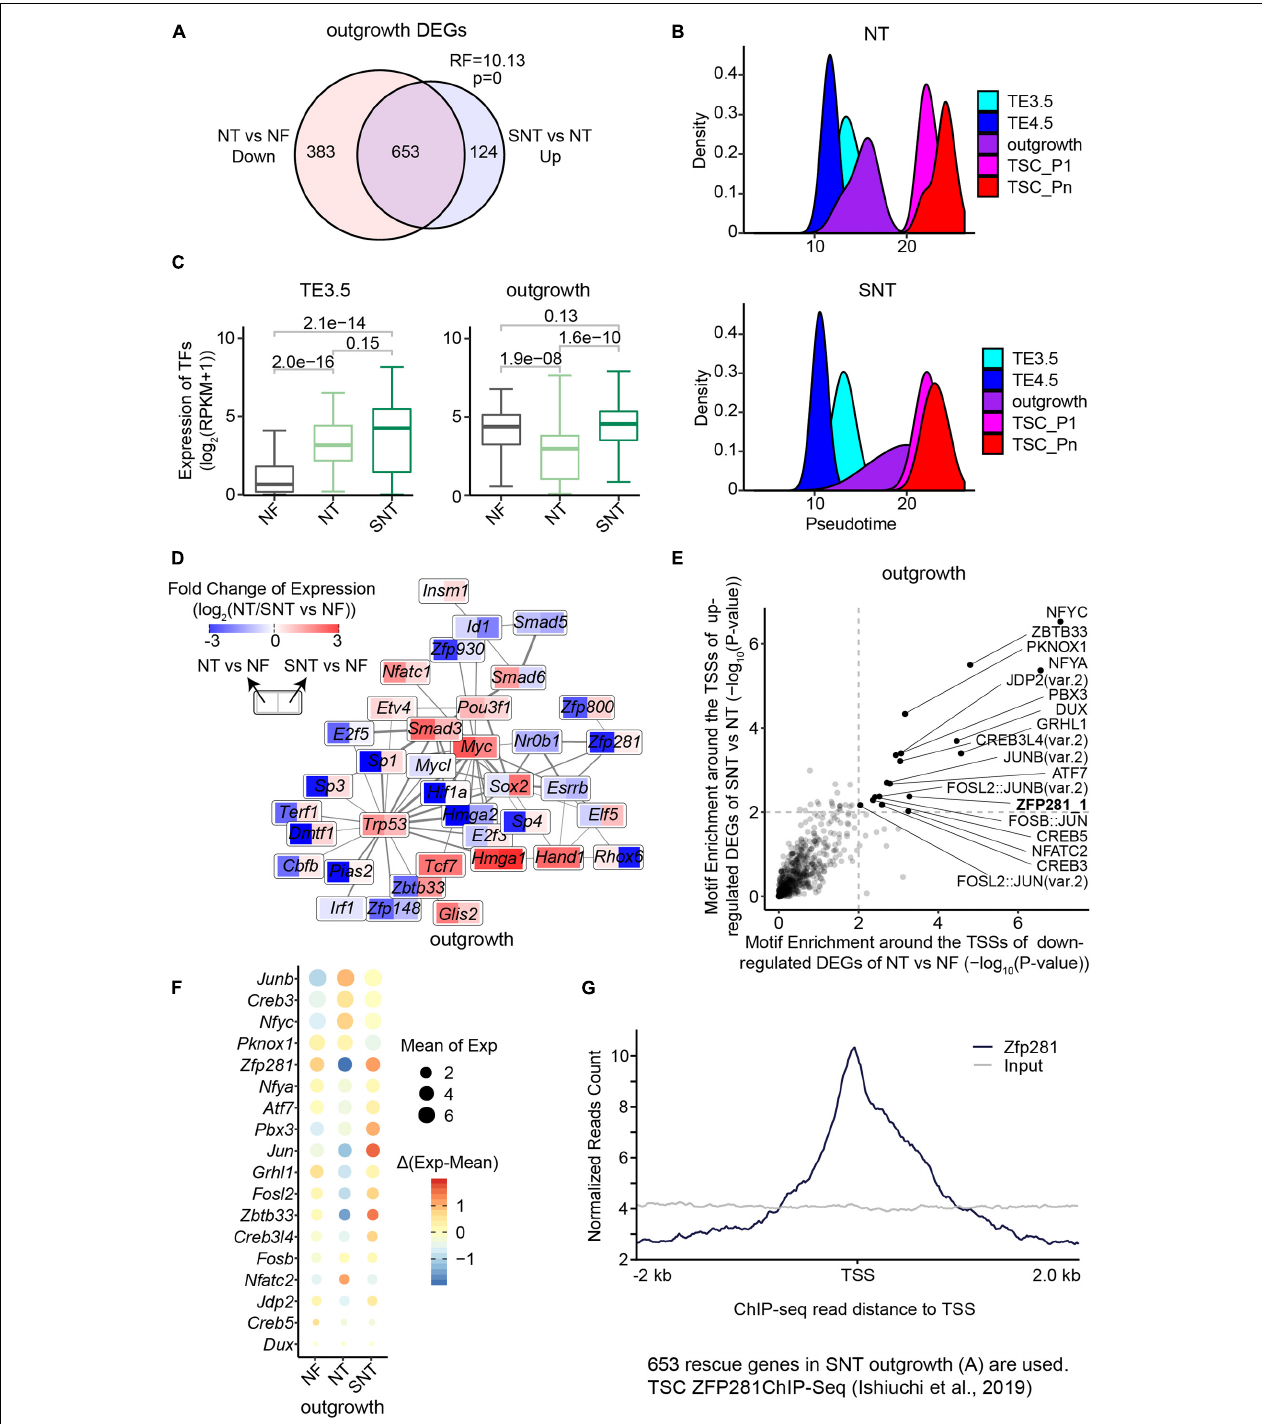
FIGURE 3 | Downregulated genes in NT outgrowth are largely rescued in SNT outgrowth. (A) Venn diagrams showing the intersection between the downregulated genes in NT outgrowth compared with NF outgrowth and the upregulated gene SNT outgrowth compared with NT outgrowth. Representation factor (RF) was calculated using real observation/expected observation. The statistical analysis is hypergeometric test with all expressed genes at outgrowth as background. The intersection genes are defined as the rescued genes. (B) The pseudotime of NT (top) or SNT (bottom) TSC derivation inferred from the transcriptomes of the 75 TFs in Clusters 1–3 ( Supplementary Figure 3D ). (C) Boxplots showing the expression of the 75 TFs in Clusters 1–3. Paired t -test is performed for statistical comparisons, and “holm” is used for adjusting p -values. (D) Expression changes of the component TFs in the PPI network ( Figure 2D ) in NT outgrowth are